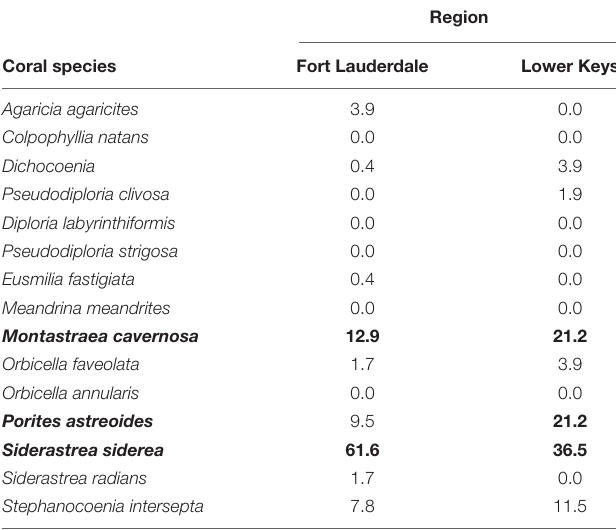
TABLE 1 | Coral community structure at two sites surveyed for disease in November,